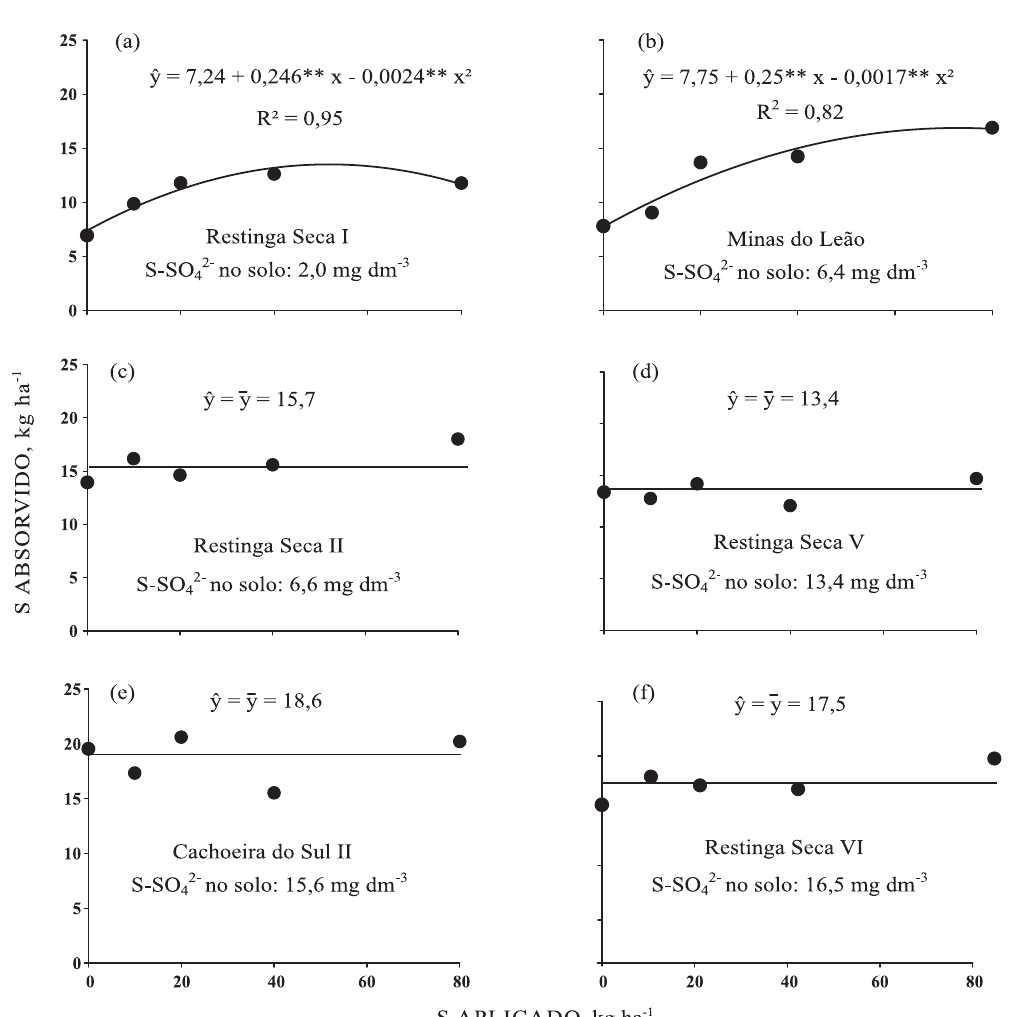
Figura 1. Enxofre absorvido pelo arroz irrigado, em função da aplicação de doses deste elemento em diferentes locais, na safra 2005/2006. **Significativo pelo teste F (p <